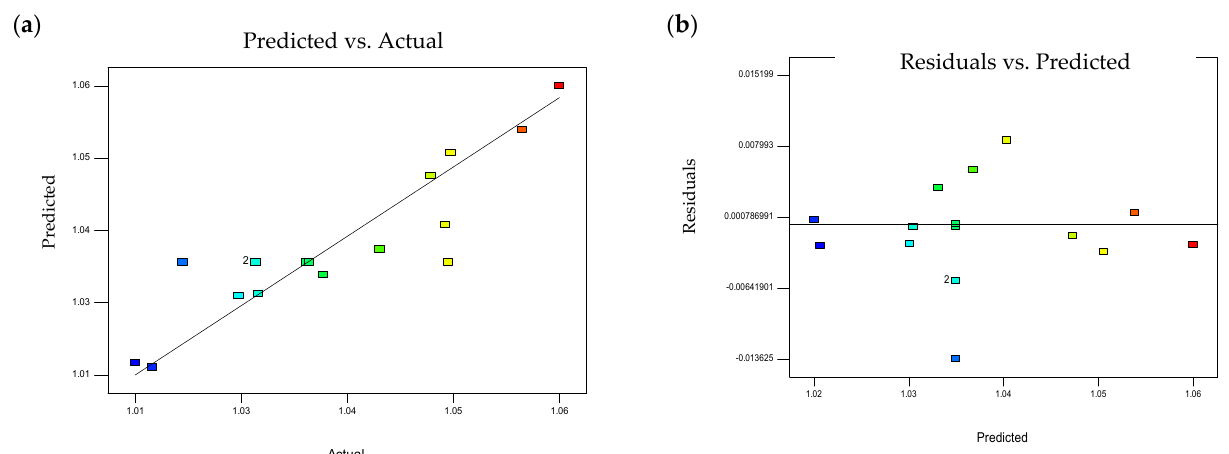
Figure 10. CFRP exit delamination analysis for ( a ) actual and predicted plot and ( b ) predicted and residual plot.